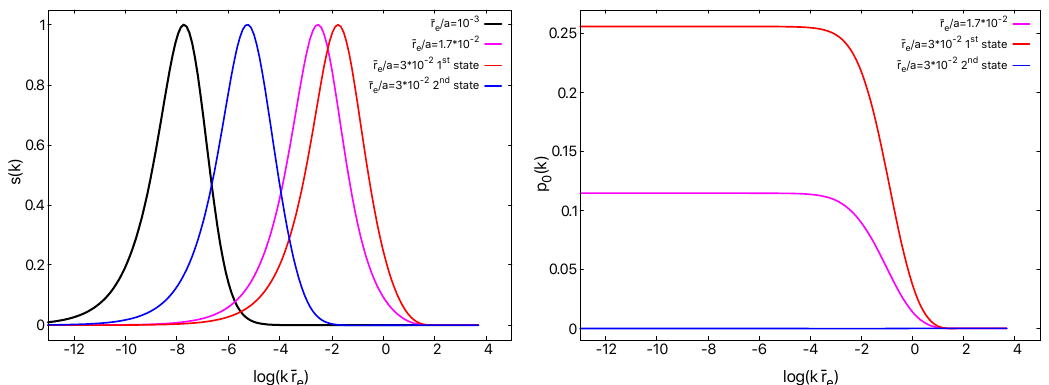
Figure 7: Components s (left panel) and p (right panel) of the wave function in 0 Eq. (23) in vicinity of the crossing between the s-wave and the p-wave induced / v = − 3 (see the top right panel of Fig. 6). The trimers for a mass ratio x = 9 at ¯ r 3 e / a = 10 − 3 (well component p is negligible and not plotted (see section 5.1). For ¯ r e 2 before the crossing), the s-wave induced trimer (black) is indistinguishable from the / a = 1.7 × 10 − 2 , the s-wave induced trimer (magenta) hybridises KM state. For ¯ r e / a = 3 × 10 − 2 (after the crossing) with the (virtual) p-wave induced trimer. At ¯ r e there are two trimers: the first state (ground state) shown in red and the second state (excited state) shown in blue.